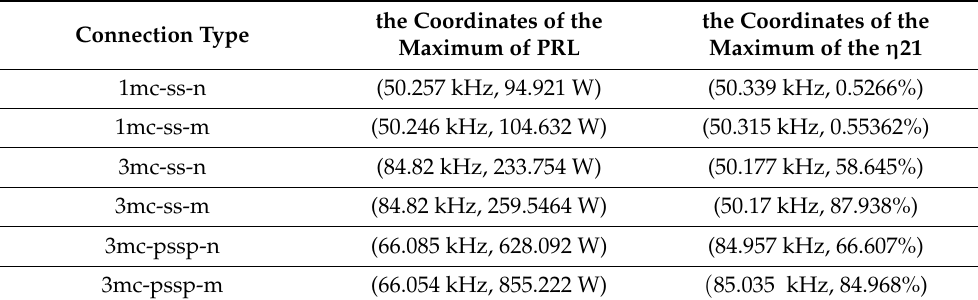
Table 1. Maximum values of the load transferred power and maximum